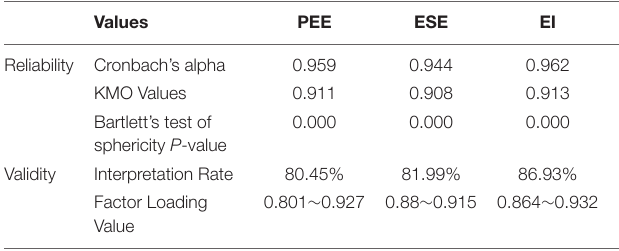
TABLE 1 | Reliability and Validity of the Post-pandemic Entrepreneurial Environment, Entrepreneurial Self-Efficacy, and Entrepreneurial Intention Scales. Values PEE ESE EI